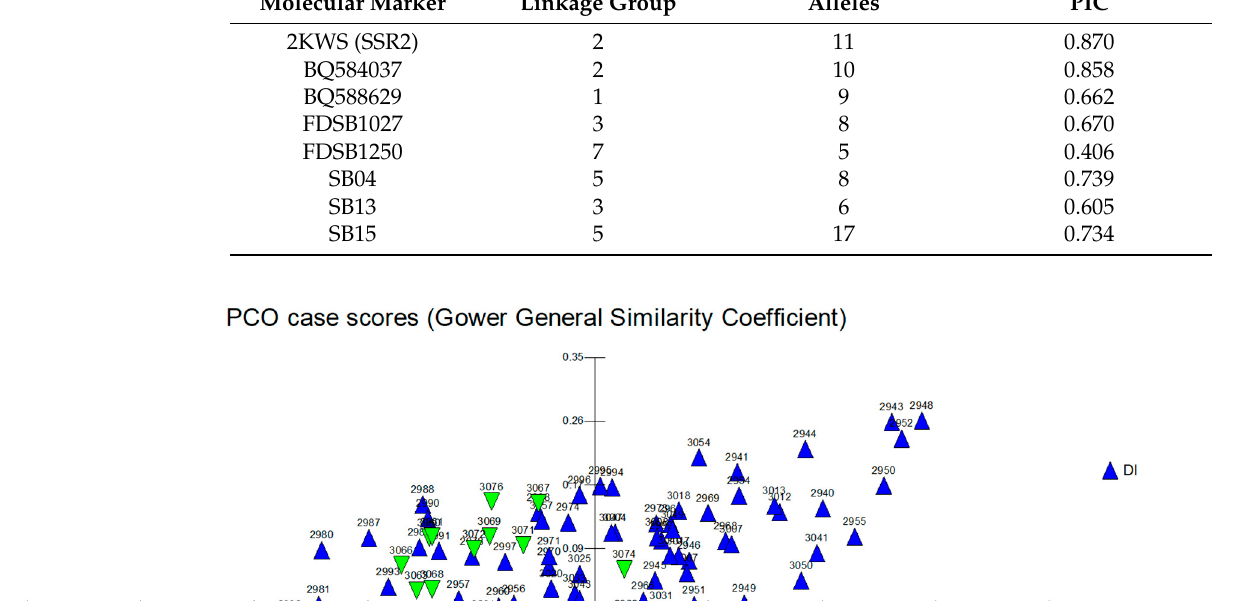
(FDSB1027) to 0.1575 (BQ584037) (Table 3). Both these measures ( H ′ and F IS ) are somewhat